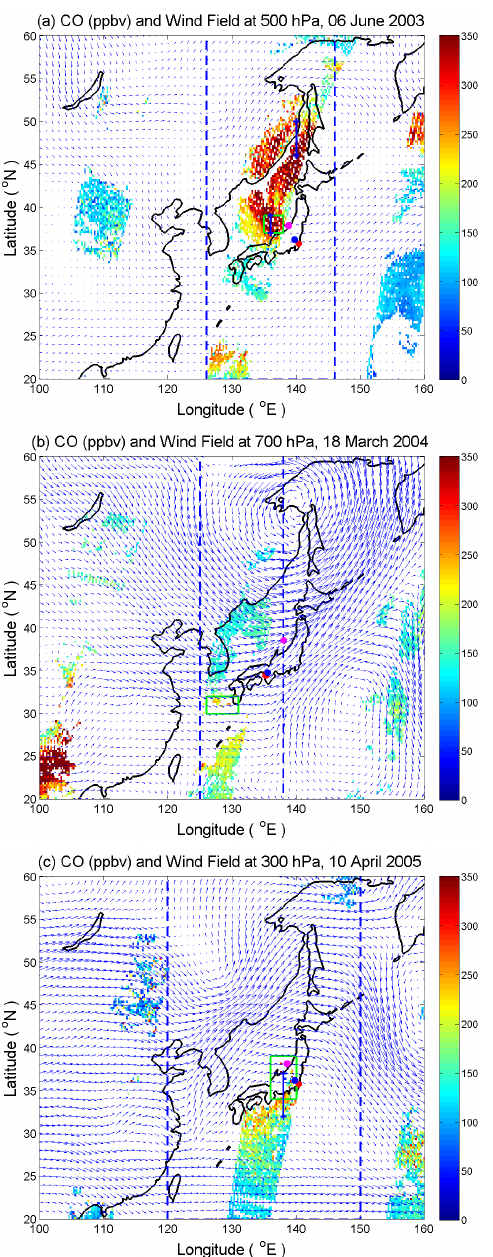
Figure 4. MOPITT CO mixing ratio (ppbv, in color) (a) on 6 June 2003 at 500hPa, (b) on 18 March 2004 at 700hPa, and (c) on 10 April, 2005 at 300hPa. All are overlaid with horizontal winds (in arrows) at the same altitude. In each subfigure, the locations of MOZAIC data at 900, 600, and 300hPa are indicated as red, blue and pink dots, respectively. The box indicates an area over which mean MOPITT CO profile is taken and displayed in Fig. 5. The box is selected to ensure enough MOPITT samplings at the closest upwind direction of MOZAIC measurements. The two blue dashed lines define the longitudinal zone, over which the CO abundances were averaged and shown in Fig. 6. The solid blue bars in Fig. 4a and c indicate the locations where particles were released and back- ward trajectories were simulated using FLEXPART (see text for de- tail).